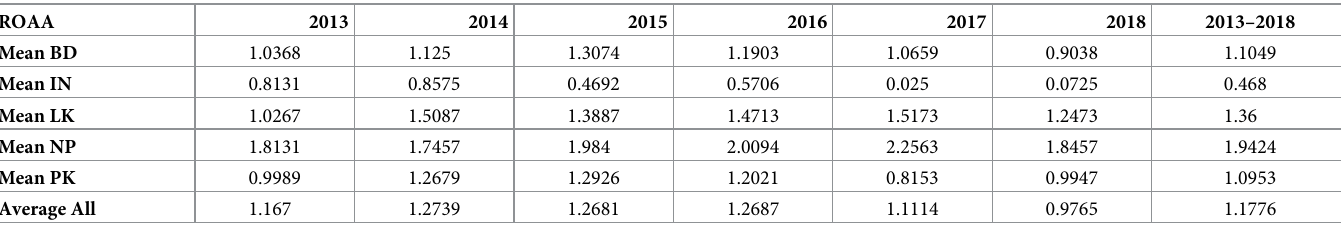
Table 2. Average of returns on assets (AROA) of 147 SA CBs. ROAA